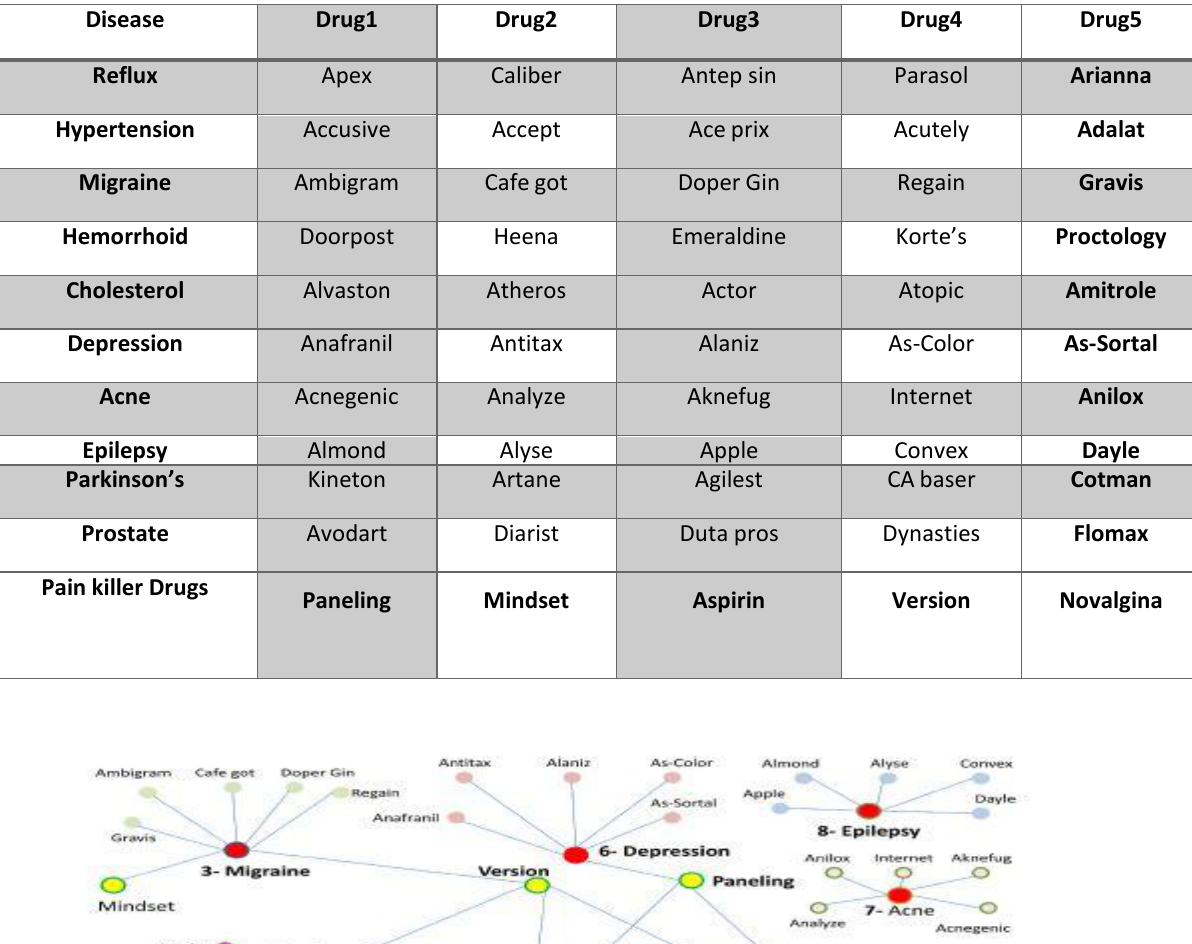
Table 2. Diseases and Drugs used in database